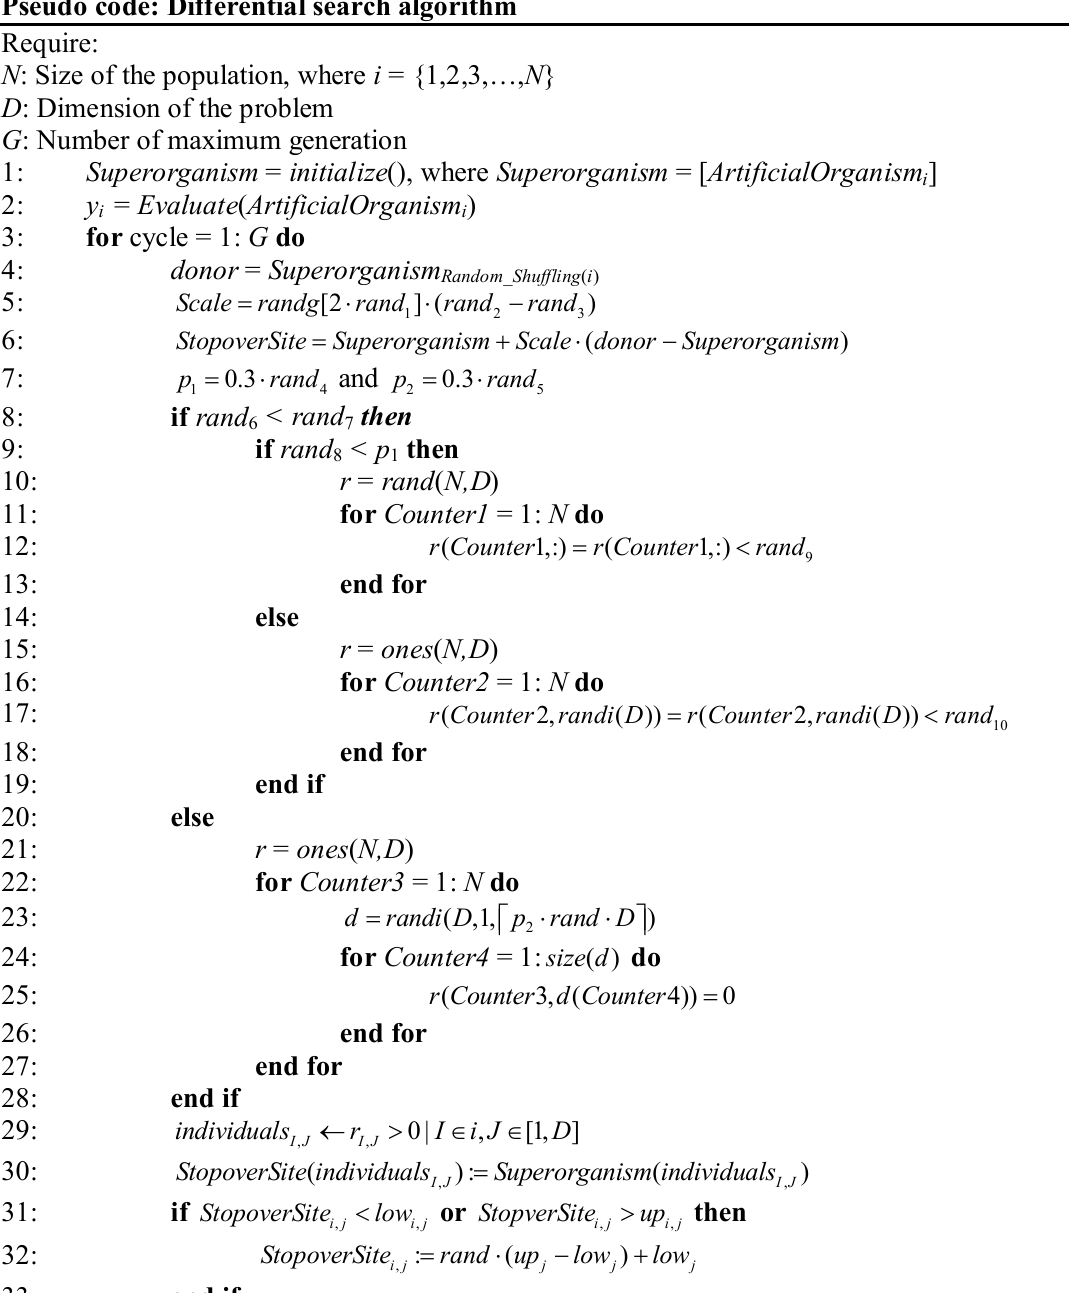
Pseudo code: Differential search